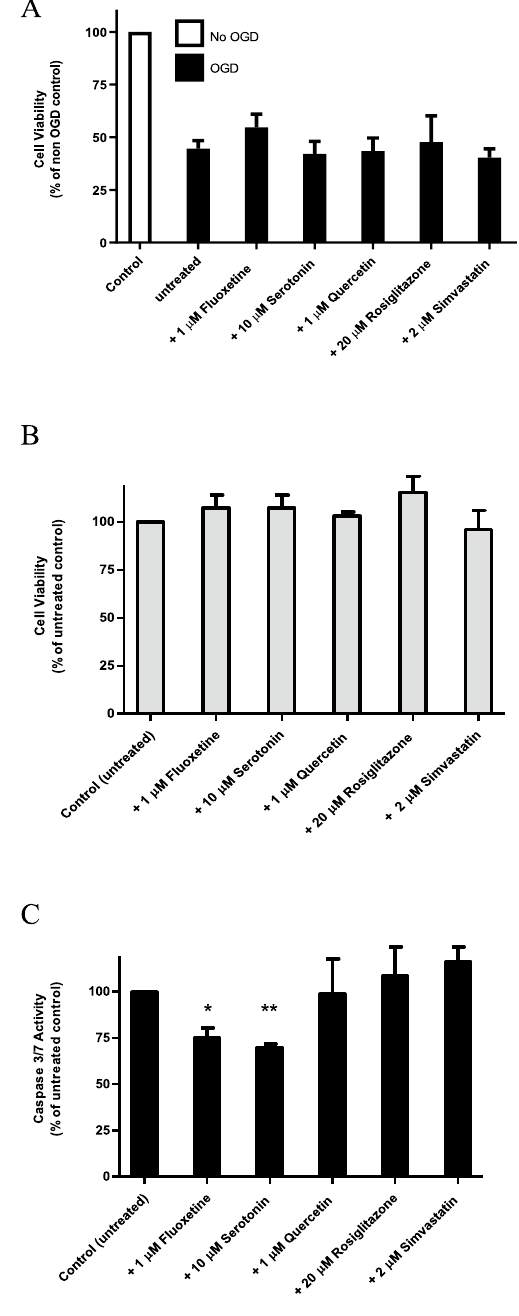
Figure 5. Application of PC12 NS-1 in vitro stroke model. ( A ) After 3-h OGD, NGF-differentiated NS-1 cells were incubated at normal conditions and treated with the indicated drugs as described under “Drug treatment”. Cell viability was determined by MTT assay. Data was normalised to untreated control cells. ( B ) Differentiated, non-OGD PC12 NS-1 cells were treated with the indicated drugs as described under “Drug treatment”. Cell viability was measured with MTT assay. Data was normalised to untreated control. ( C ) NGF-differentiated NS-1 cells were subjected to 3-h OGD followed by 24 h incubation at normal conditions with the indicated drugs as described under “Drug treatment”. Caspase 3/7 activity was measured. Non-OGD baseline activity was removed and data normalised to untreated cells. *p < 0.05 compared to control untreated cells; **p < 0.01 compared to control untreated cells. All data are expressed as mean ± SEM of 3 experiments determined in